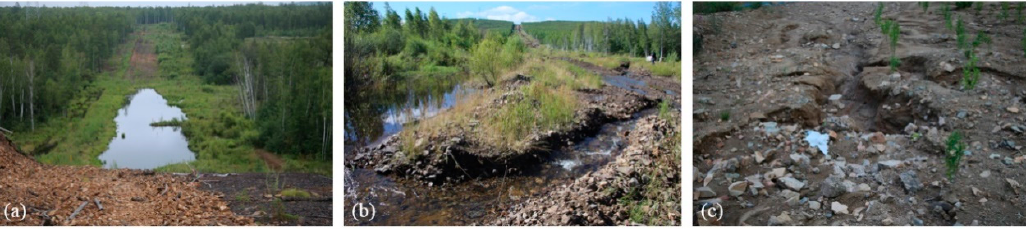
Figure 6. (a) Ponding, (b) erosive damage from streams on flat ground, and (c) and surface flow on a slope .